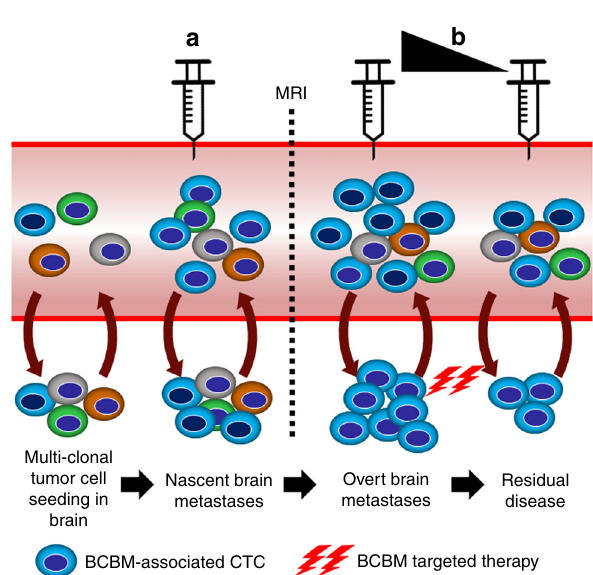
Figure 5 Translational perspectives of employing CTC testing for BCBM patients. Model illustrates clinical implications of BCBM CTC characterization. a Enumeration of BCBM CTCs can be used as a screening method for brain micro-metastasis before they become detectable by MRI. b Serial estimation of BCBM-associated CTCs can be used as a tool to evaluate responses to therapy for BCBM patients, i.e., the reduction of Notch1+ CTCs and/or Ki67+/uPAR+/int- β 1+ CTCs,